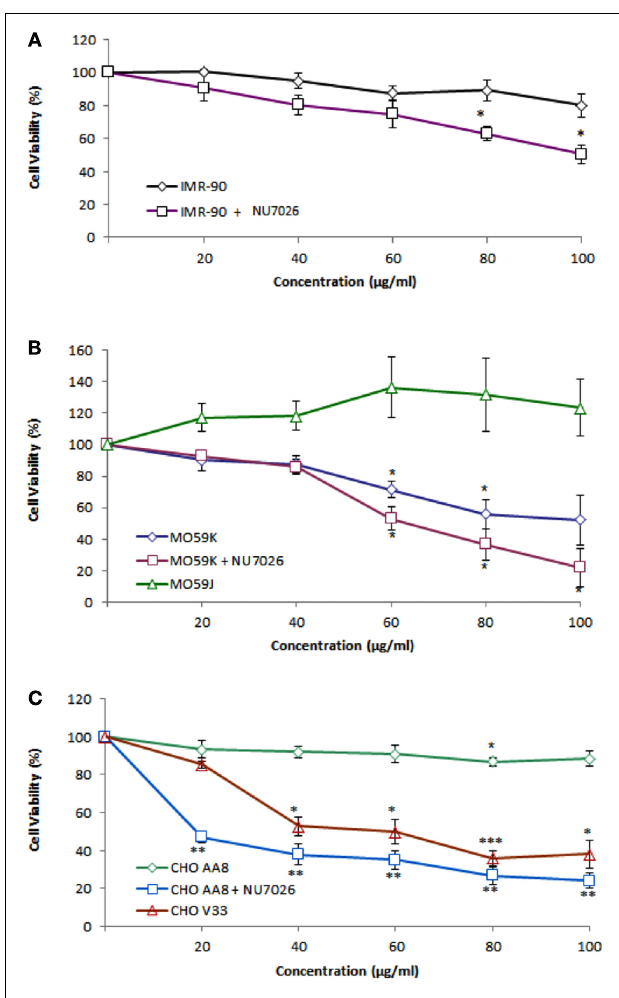
FIGURE 2 | Cell viability in mammalian cells followingAg-np treatment. Cell viability of (A) IMR-90 cells, (B) MO59K and MO59J cells, and (C) CHO AA8 and CHOV33 cells after 48h treatment with Ag-np at different concentrations is shown.The cell viability percentage was normalized against the untreated controls (0 μ g/ml) for Ag-np treatment alone or DMSO control (0 μ M) for each cell type pre-treated with NU7026 (10 μ M).The values represent the mean ± standard error of three sets of independent experiments; *denotes p < 0.05; **denotes p < 0.01; and ***denotes p < 0.001 as obtained using Student’s t -test, where the statistical significance between controls and Ag-np treated samples was